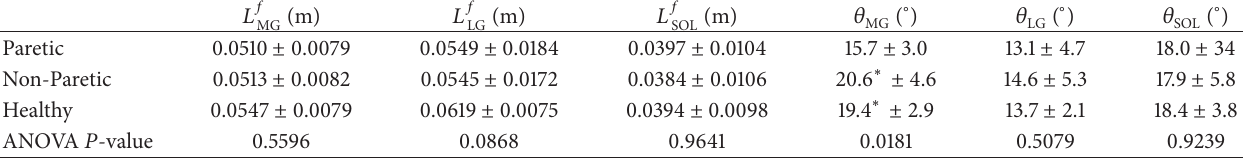
Table 2: Fascicle lengths and pennation angles for post-stroke and healthy adults ( ± SD).